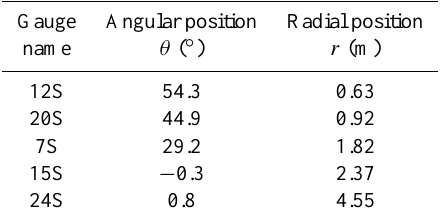
Table 1. Angular and radial position of sea level gauges: the point where the landslide impacts the water is taken as the origin, and the angular position is taken counterclockwise from the landslide motion direction (see Fig. 3).